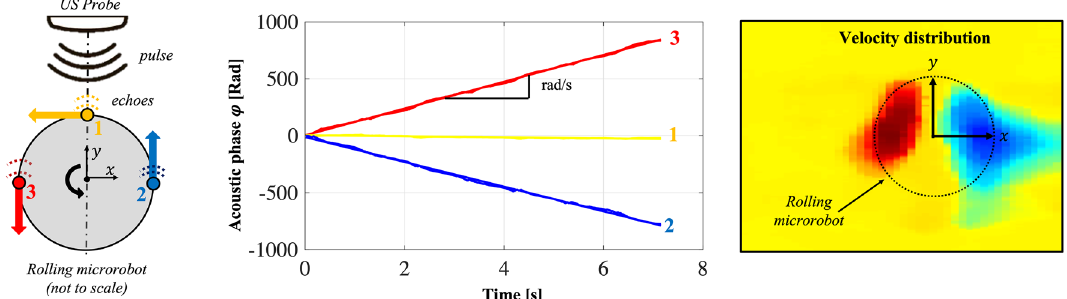
Figure 1. Acoustic phase shifts in the backscattered echoes induced by MR rotations. The dashed line represents the direction of wave propagation, namely the acoustic axis (y). Points in positions 2 and 3 continuously move respectively towards and out from the US probe, producing a continuous shift (with opposite sign) in the acoustic phase of received echoes. On the other hand, points in position 1 and all points along the acoustic axis y are not moving with respect to the probe. These rotating motion features produce a specific velocity distribution, which can be exploited for MR detection and visualization.